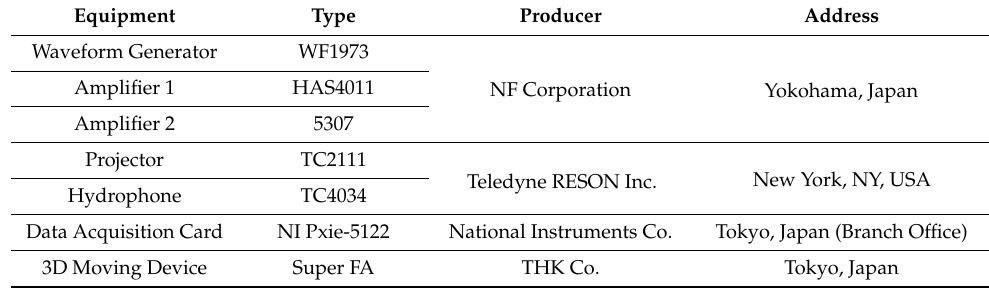
Figure 3. Structure of experiment system. Figure 4. Experiment system: ( a ) signal generator and receiver, including wave generator, two amplifiers and data acquisition card; ( b ) moving system, including moving device, projector and hydrophone.